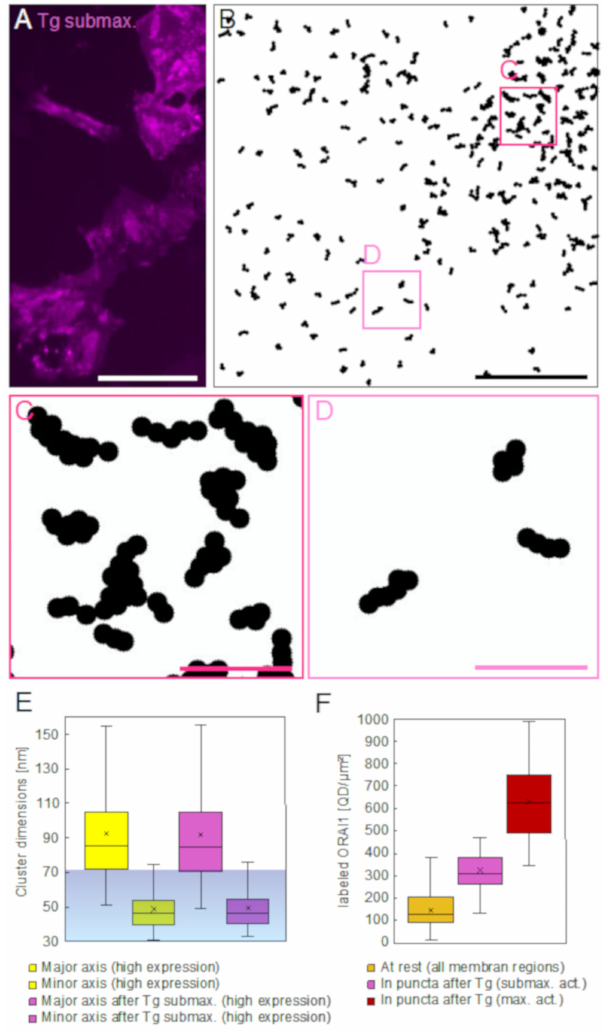
Figure 4. ORAI1 distributions 15 min after Tg in sub-maximally SOCE-activated cells (expressing ORAI1 and STIM1 in a 1:1 ratio). ( A ) Fluorescence microscopy image of the QD signal showing accumulations of ORAI1 in bright patches. Most of these regions with dense ORAI1 distributions are larger and blurrier than the puncta found after maximal SOCE-activation (compare to Figure